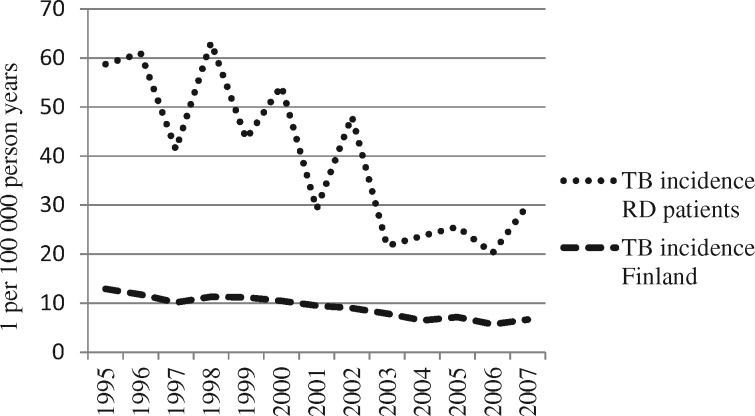
Tuberculosis incidence in Finland, 1995–2007Annual incidences (one per 100 000 person years) of tuberculosis (TB) in Finland among the general population as reported by the National Infectious Disease Register (NIDR) were significantly lower (P < 0.01) than incidences among patients with rheumatic disease (RD). The incidence of both diminished during the study period (P < 0.05).